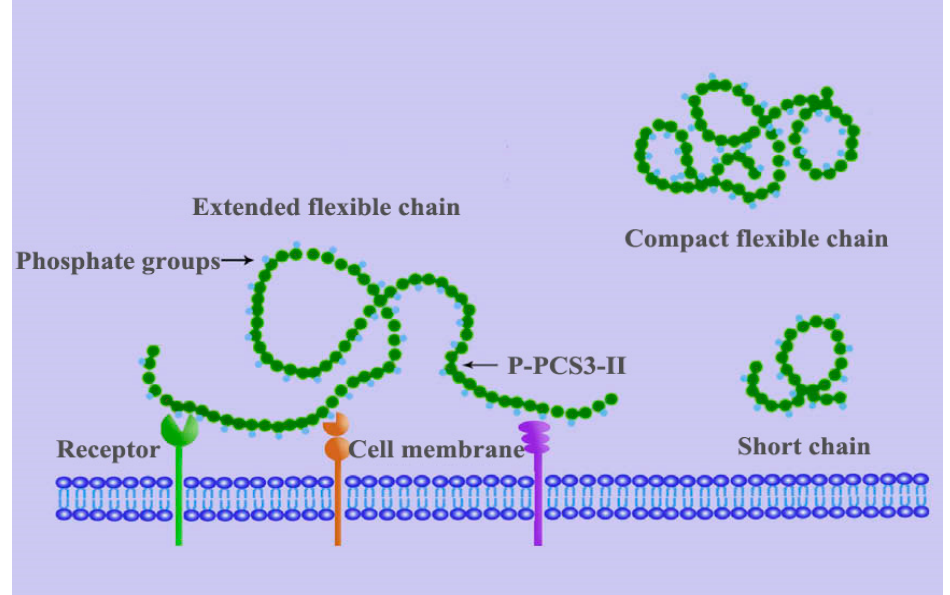
Figure 5. Schematic depiction of the interaction between the phosphorylated pachymaran P-PCS3-II chain and receptors on the immune cell (reprinted from Carbohydr. Polym. , 78 , Chen, X.; Xu, X.; Zhang, L.; Zeng, F., Chain conformation and anti-tumor activities of phosphorylated (1 → 3)- β - D -glucan from Poria cocos , pp. 581–587, Copyright (2009), with permission from